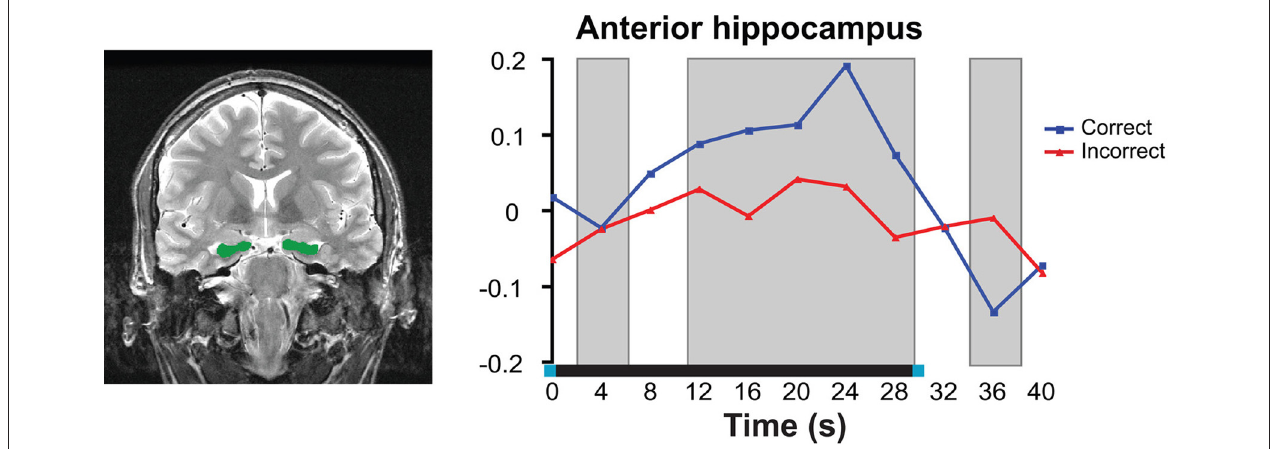
FIGURE 3 | Neuroimaging data from high-resolution fMRI in the anterior hippocampus during a short-delay recognition task. Left: Anatomical region of interest outlined in green; right: Neural response averaged across all voxels within the anterior hippocampus.